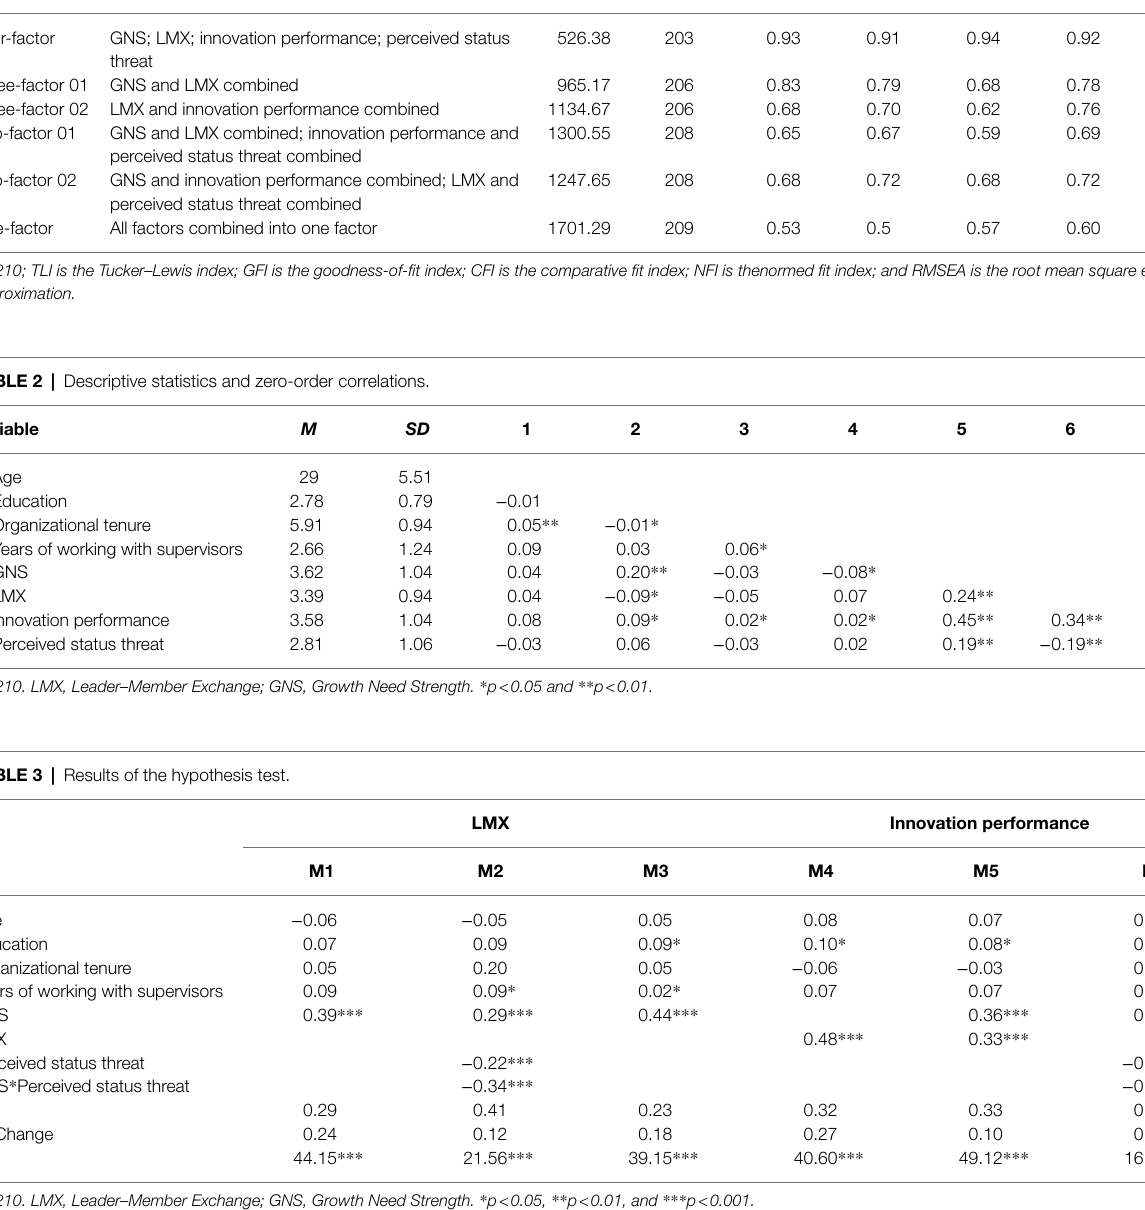
TABLE 1 | Results of confirmatory factor analysis (CFA). Models